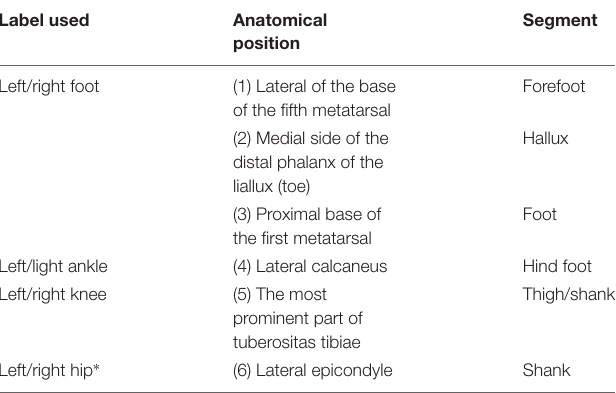
TABLE 2 | Labels and anatomical positions of ProReflex